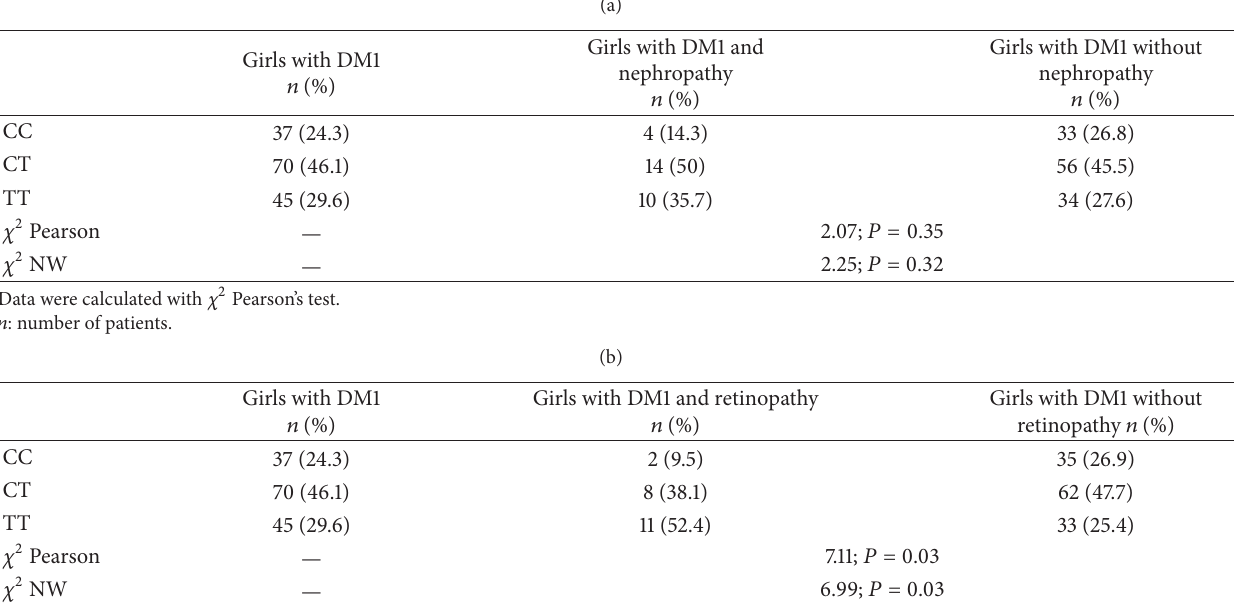
Table 3: (a) Distribution of IVS − 397T > C genotypes in type 1 diabetic girls with nephropathy. (b) Distribution of IVS1 − 397T > C genotypes in type 1 diabetic girls with retinopathy.